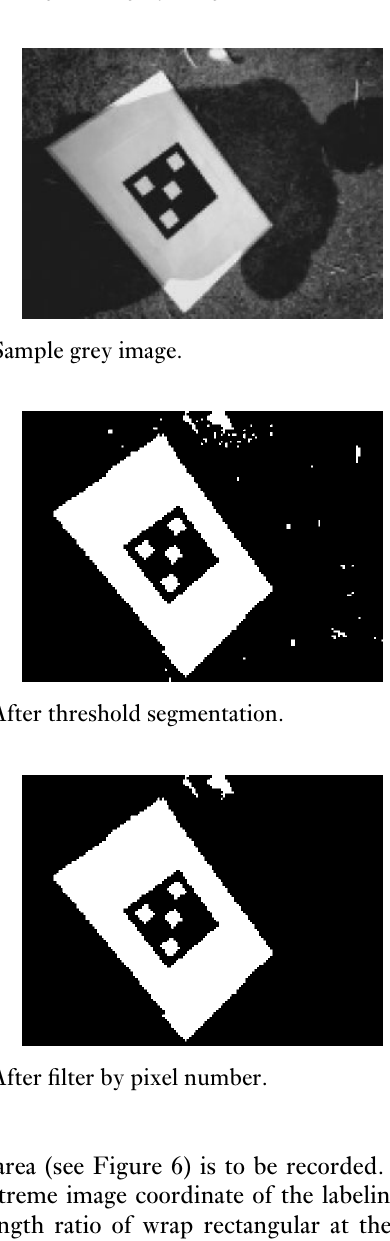
Figure 3 Histogram of grey image.